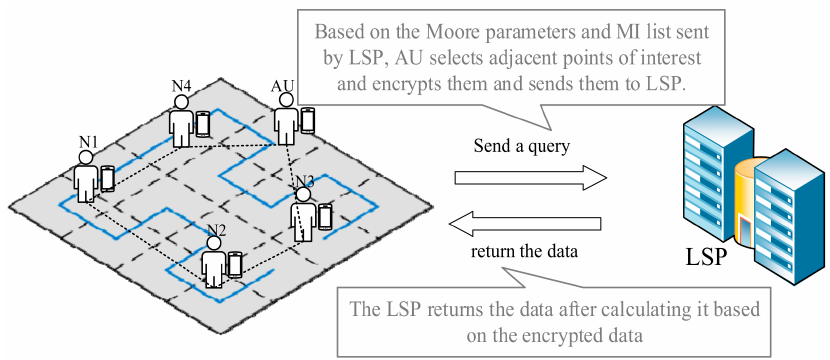
Figure 2. Query system